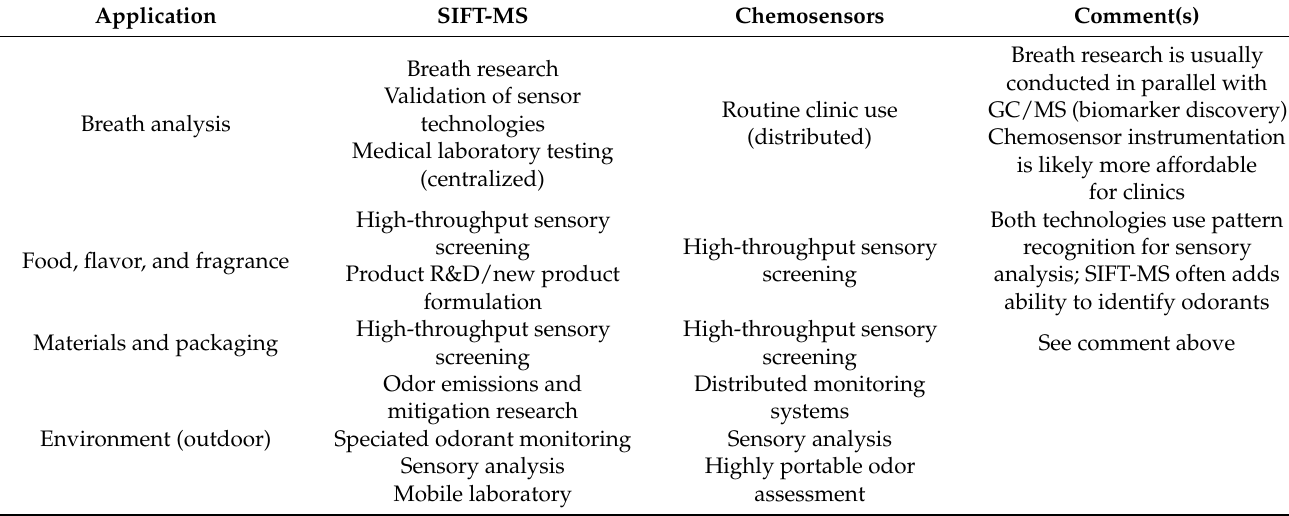
Table 4. The complementary nature of SIFT-MS and chemosensor detection of odorous compounds in the application areas discussed in Section